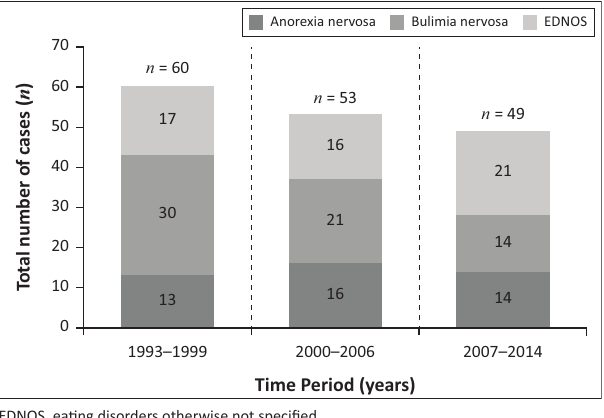
FIGURE 1: The changing patterns of cases seen at the eating disorder unit at Tygerberg Hospital between 1993 and